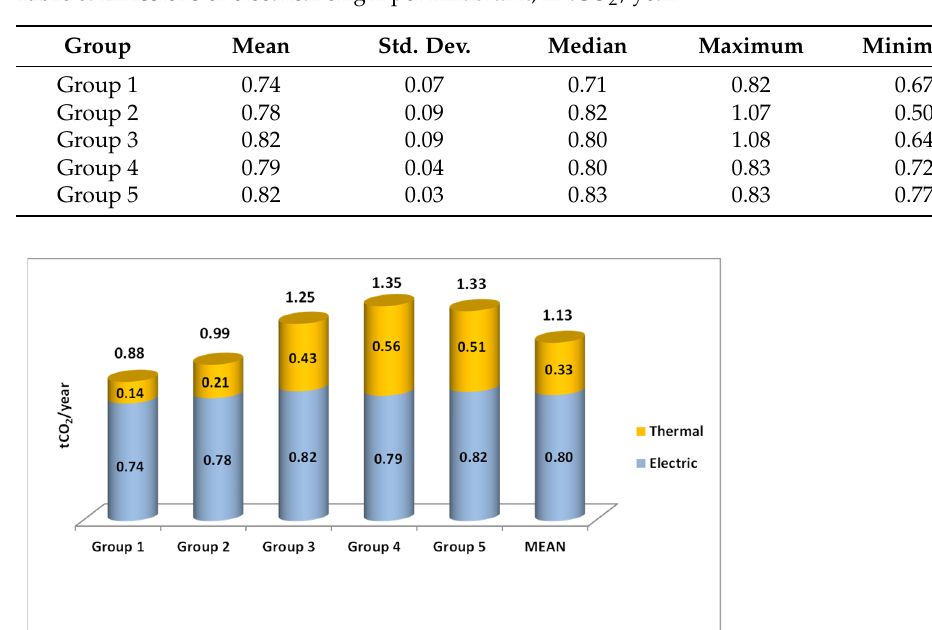
Figure 8. Thermal, electric, and total mean CO 2 emissions per inhabitant by group.